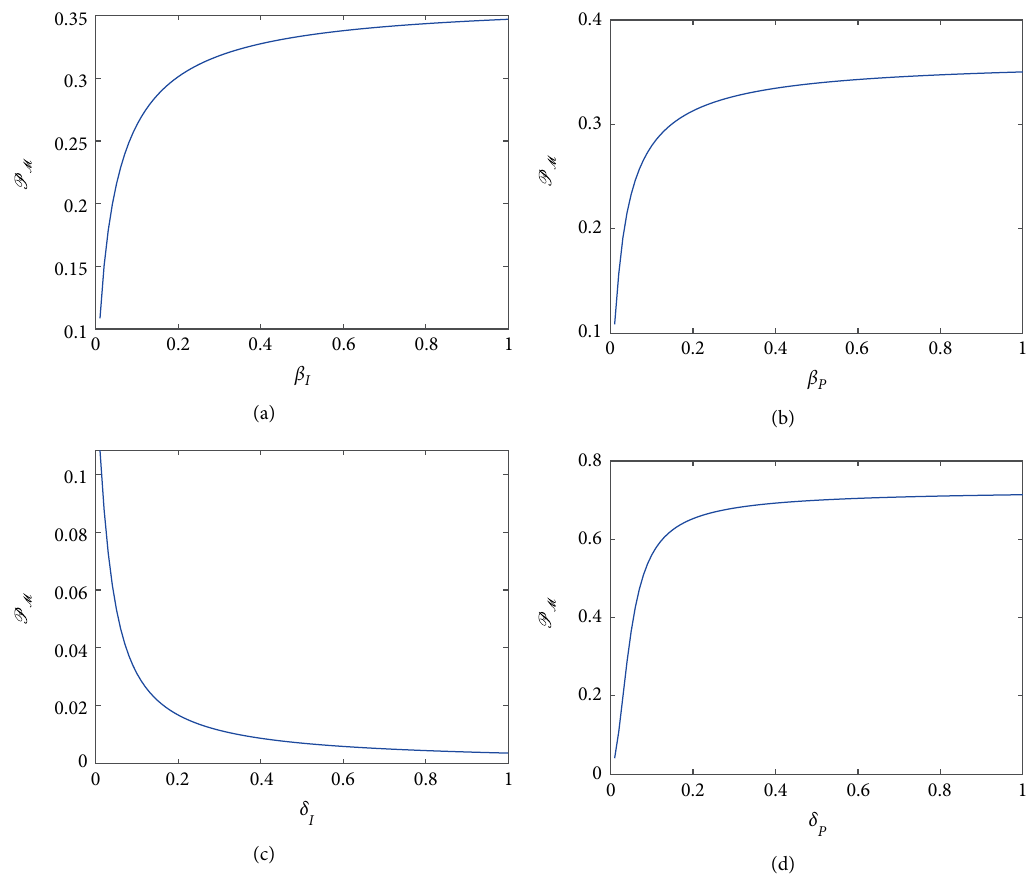
, , , and on P M in Examples 12, 13, 14, and 15, (𝛾 𝐼 , 𝛾 𝑃 ) 𝛽 𝐼 𝛽 𝑃 𝛿 𝐼 𝛿 𝑃